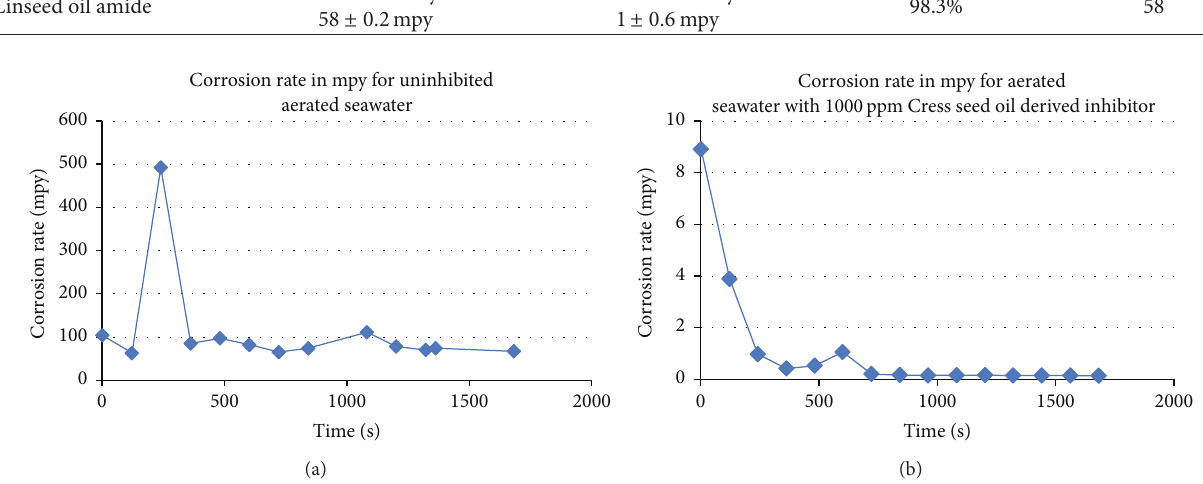
Table 1: Summary of corrosion rates as measured by linear polarization resistance showing the effectiveness of the inhibitors synthesized. Oil Cress seed oil amide Linseed oil amide